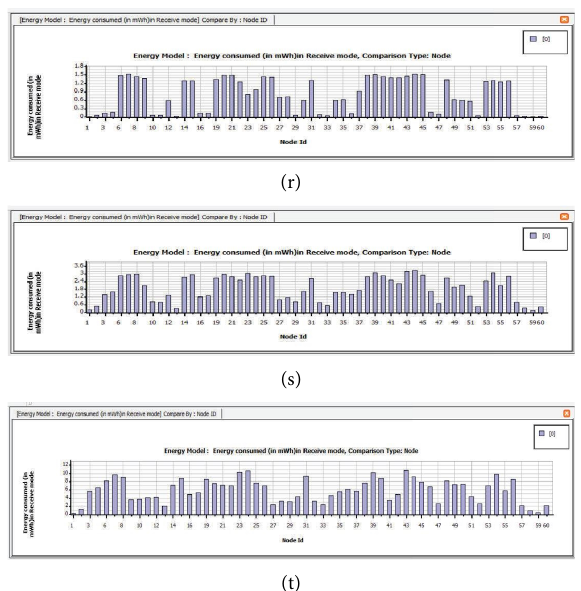
Figure 11: (a) Receive mode power consumption (mWh) of AODV for 60 nodes. (b) Receive mode power consumption (mWh) of DSR for 60 nodes. (c) Receive mode power consumption (mWh) of DYMO for 60 nodes. (d) Receive mode power consumption (mWh) of LAR1 for